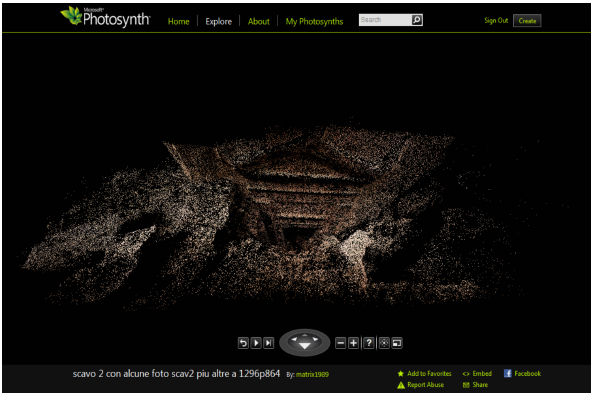
Figure 5. The sparse cloud after the orientation phase computed with Photosynth. The point clouds are suitable for a preview of the excavation directly on the web platform.